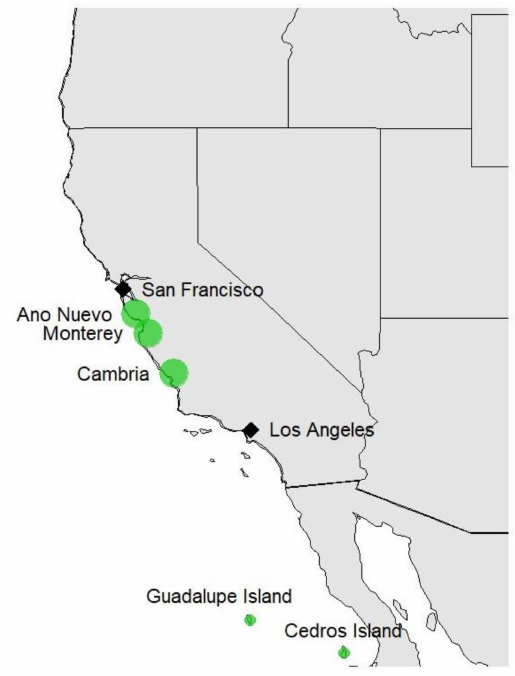
Figure 1. Natural distribution of radiata pine in North America. Table 1. Populations, families, and trial series included in genomic (GBLUP),